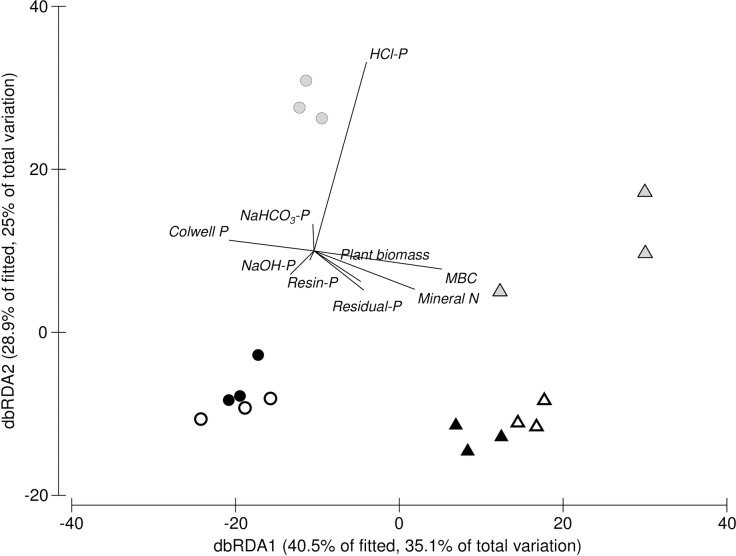
Distance-based redundancy analysis (dbRDA) of variation in bacterial community profiles as explained by environmental variables.Vectors represent correlations of variables with community structure along the first two dbRDA axes. No P amendment is represented by black symbols, rock P amendment is represented by open symbols and solution P amendment is represented by grey symbols. Application of a C:N ratio of 12.5:1 is represented by triangles and application of a C:N ratio of 50:1 is represented by circles. The values in parentheses indicate the percentages of the fitted and total variations explained by each axis.